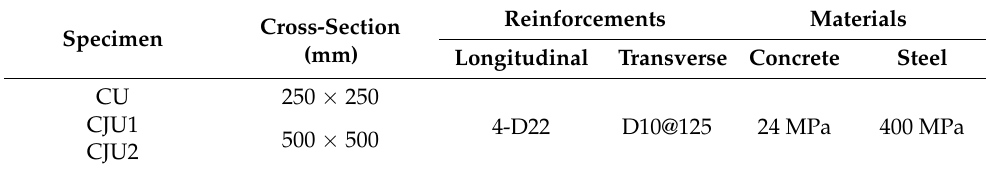
Table 2. Descriptions of the